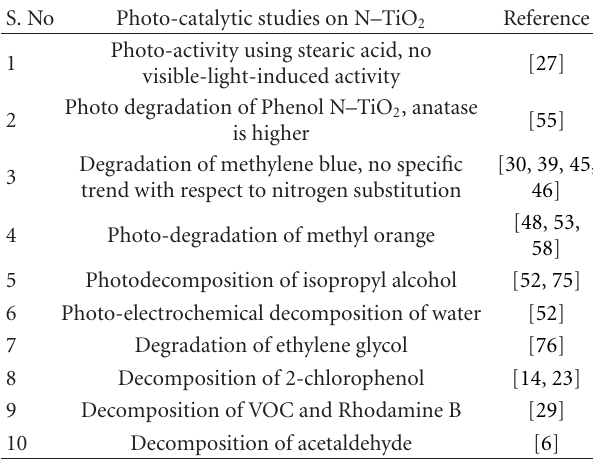
Table 3: Typical photocatalytic studies reported on N-substituted TiO 2 .